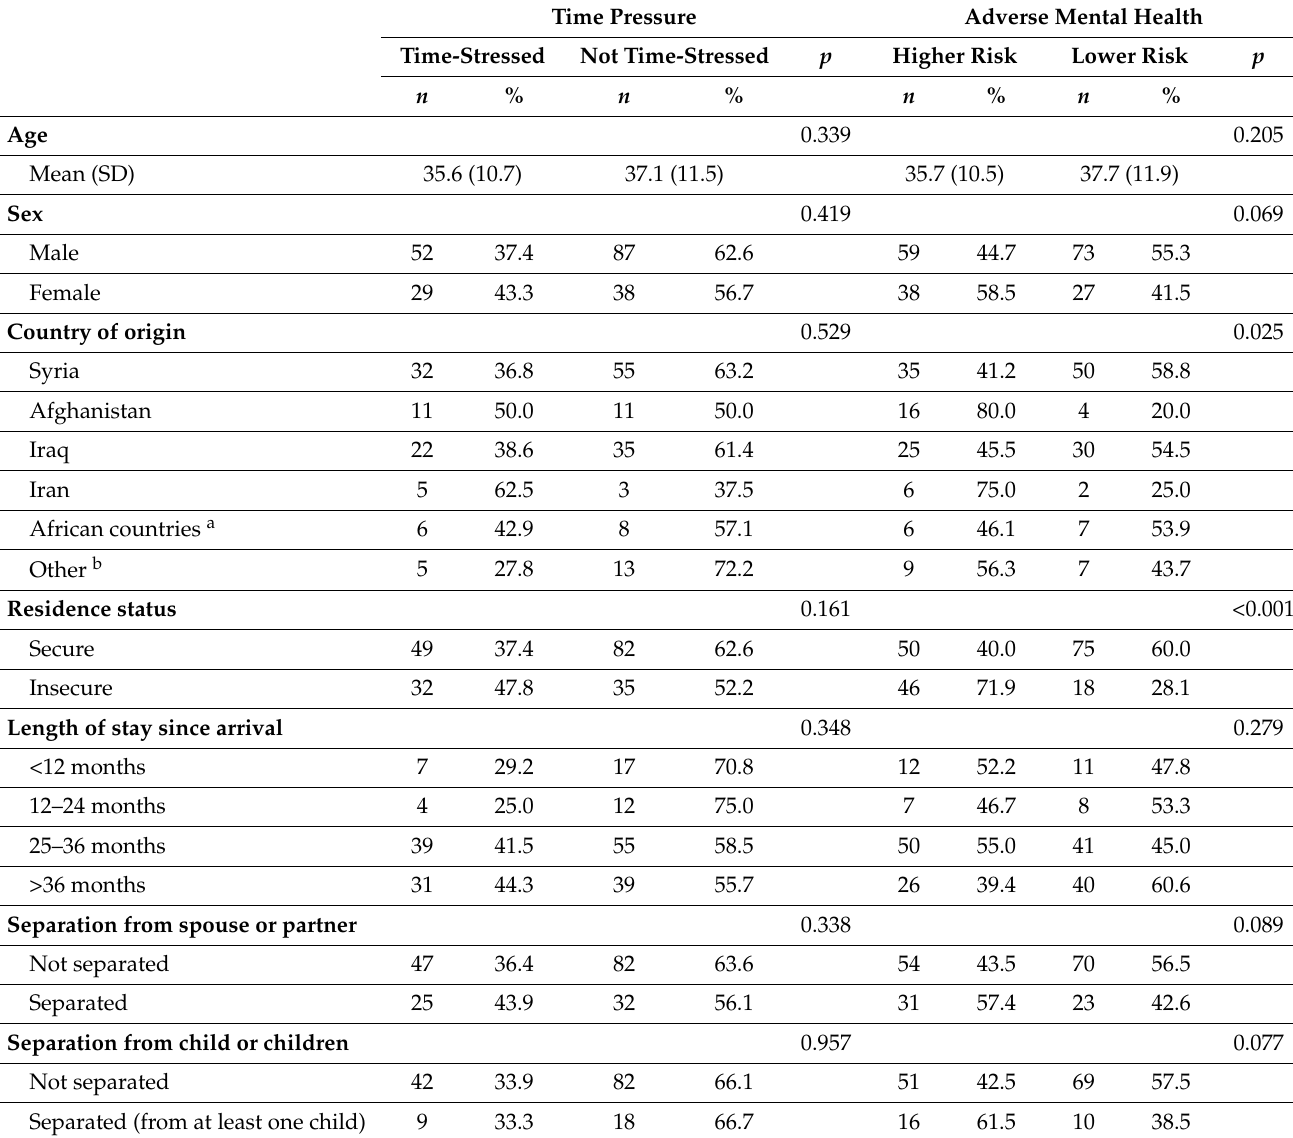
Table 2 provides detailed information on sociodemographic and postmigration factors stratified by time pressure and adverse mental health groups. More than half of the female participants were classified in the higher risk for adverse mental health group, while most male participants reported less time pressure and better mental health. Frequency in the time-stressed group increased with length of stay since arrival in Germany from 29.2% (<12 months) to 44.3% (>36 months). Nevertheless, the majority of participants who reported family separation were in the not time-stressed group but in the higher risk for adverse mental health group. Table 2. Time pressure and adverse mental health groups across independent variables ( n = 208). Time